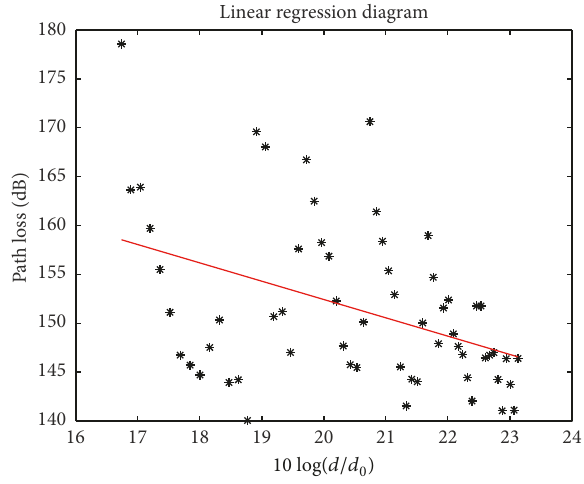
Figure 7: RouteC1 scatter-fitting line in 0.1/m 2